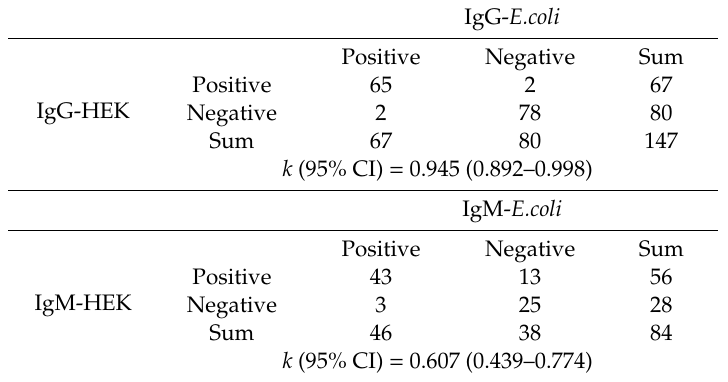
Table 2. Comparison between in-house ELISA results for E.coli -made protein and HEK-made antigen. IgG- E.coli Positive Negative Sum Positive 65 IgG-HEK